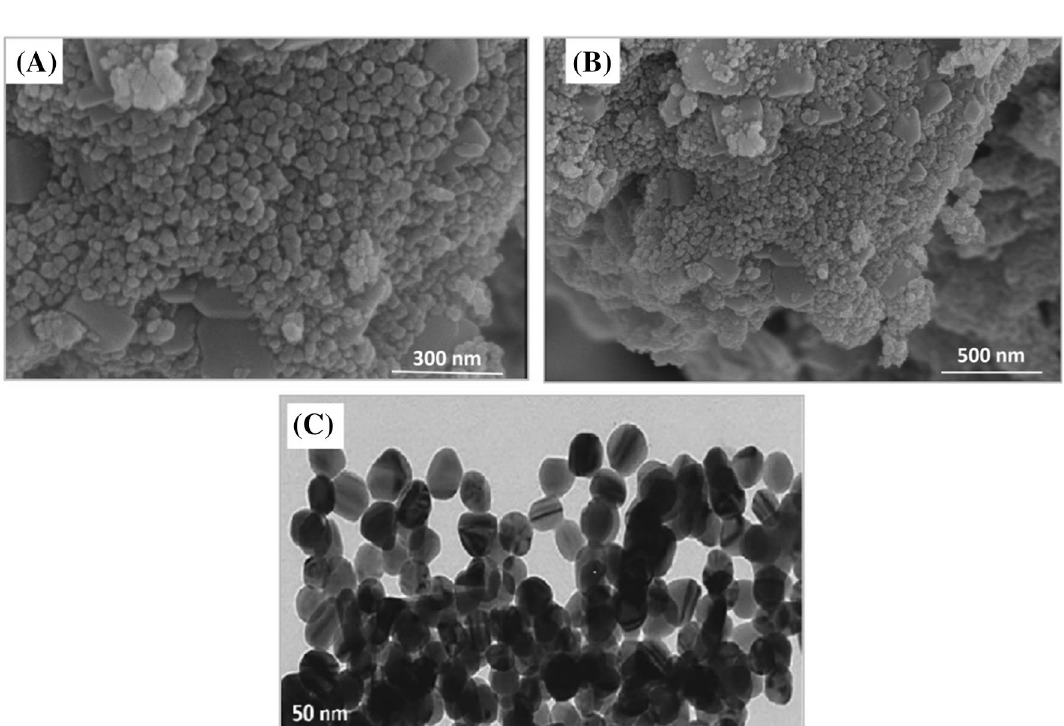
Figure 3. ( a , b ) SEM analysis of biogenic ZnONPs ( c ) TEM analysis of biogenic